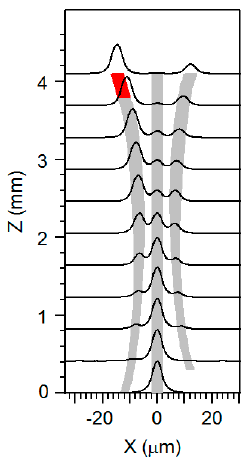
Figure 2. Power evolution for CVW splitter with the shifting length L s .